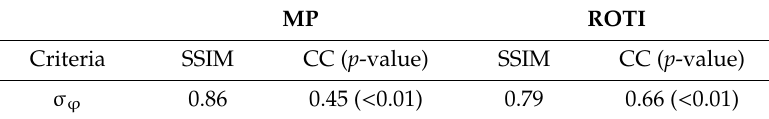
Table 17. SSIM and CC between the maps shown in Figure 15c.